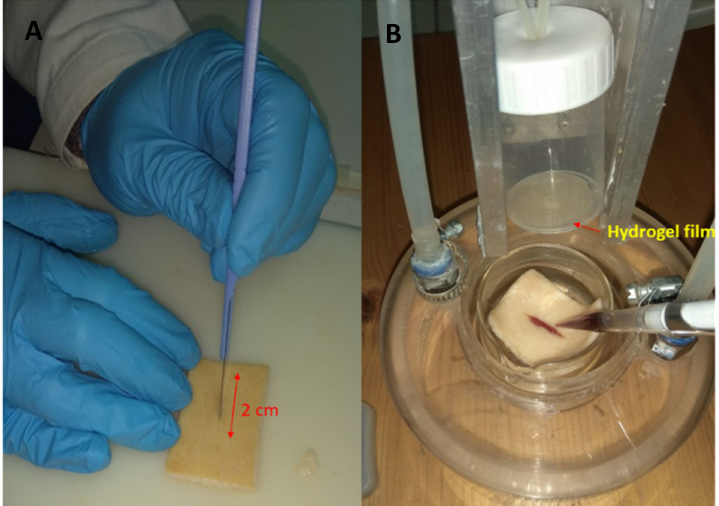
Figure 5. Skin used for the assay ( A ) and simulation of an open wound ( B